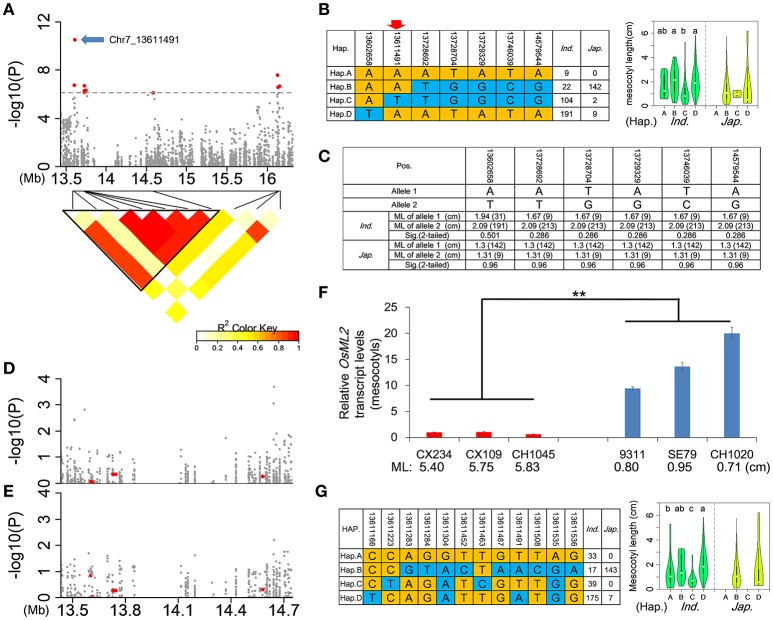
Identification of OsML2 for mesocotyl length. (A) Genome-wide association signals (top) in the region 13.4–16.4 Mb on chromosome 7 and LD heatmap (bottom) of 10 non-synonymous SNPs above the threshold. A total of 10 red points show non-synonymous SNPs above threshold in qFML7-2, qFML7-3 and qFML7-4, and blue arrow indicates possible functional locus in OsML2 (LOC_Os07g24010). Triangular block (named Block 1) shows region with strong local LD (r2 > 0.6). (B) Haplotype analysis (left) of 7 non-synonymous SNPs above threshold in Block 1 and comparison of ML (right) among haplotypes in indica and japonica. Different letters above the violins indicate significant differences (p < 0.05) when analyzed by Duncan's test. Red arrow indicates possible functional locus. (C) Independent-sample T-tests for ML differences between alleles of each of the 6 non-synonymous SNPs in Block 1 using accessions carrying allele (A) of the peak signal (Chr7_13611491). Data in parentheses show number of accessions. Manhattan plots for ML in Block 1 using (D) 373 accessions and (E) 222 indica accessions carrying allele (A) of the peak signal. Red points show 6 non-synonymous SNPs in Block 1. (F) Expression analysis of OsML2 in the mesocotyls from 6 accessions with long- and short-mesocotyls. Names and ML of accessions are plotted on the X-axis. Red and blue bars show long- and short-mesocotyl accessions, respectively. Data represent means ± s.d (n = 3). Asterisks represent significant differences between accessions with long- and short-mesocotyls (**p < 0.01, Student's t test). (G) Haplotype analysis (left) of 12 non-synonymous SNPs in OsML2 and comparison of ML (right) among haplotypes of OsML2 in indica and japonica, respectively. Different letters above the violins indicate significant differences (p < 0.05) detected by Duncan's test.